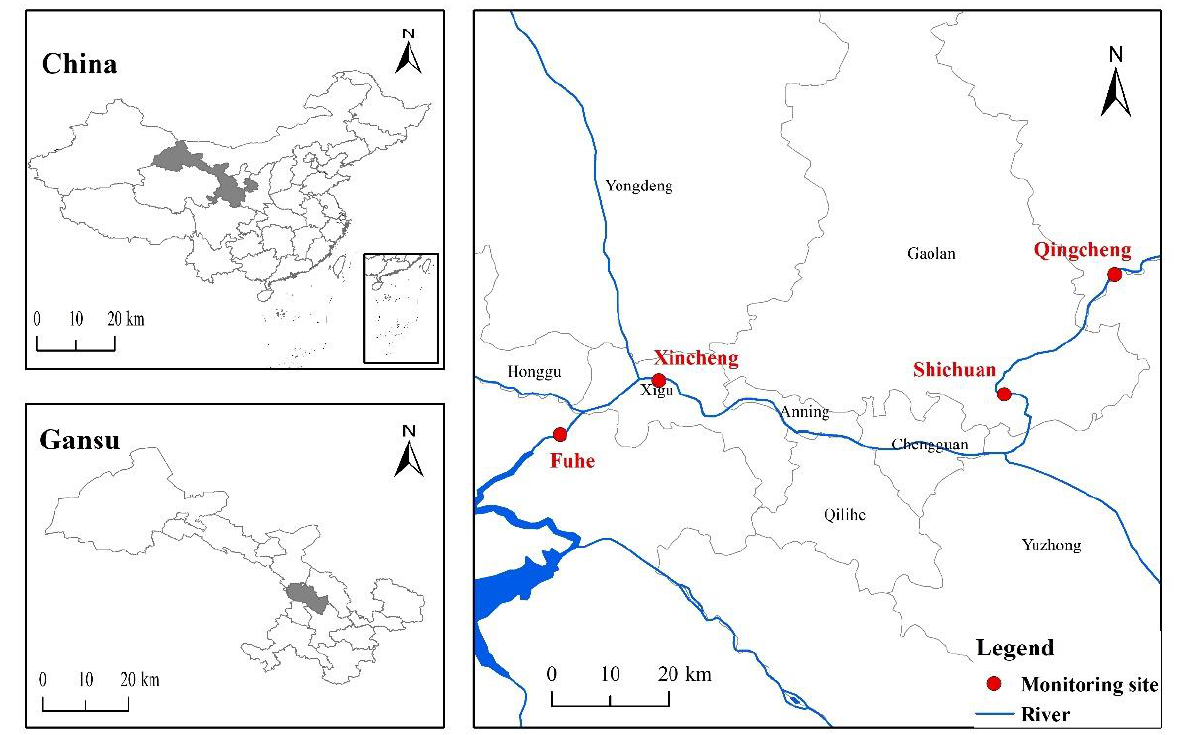
Figure 1. Cross-sectional distribution map of the Lanzhou portion of the Yellow River.